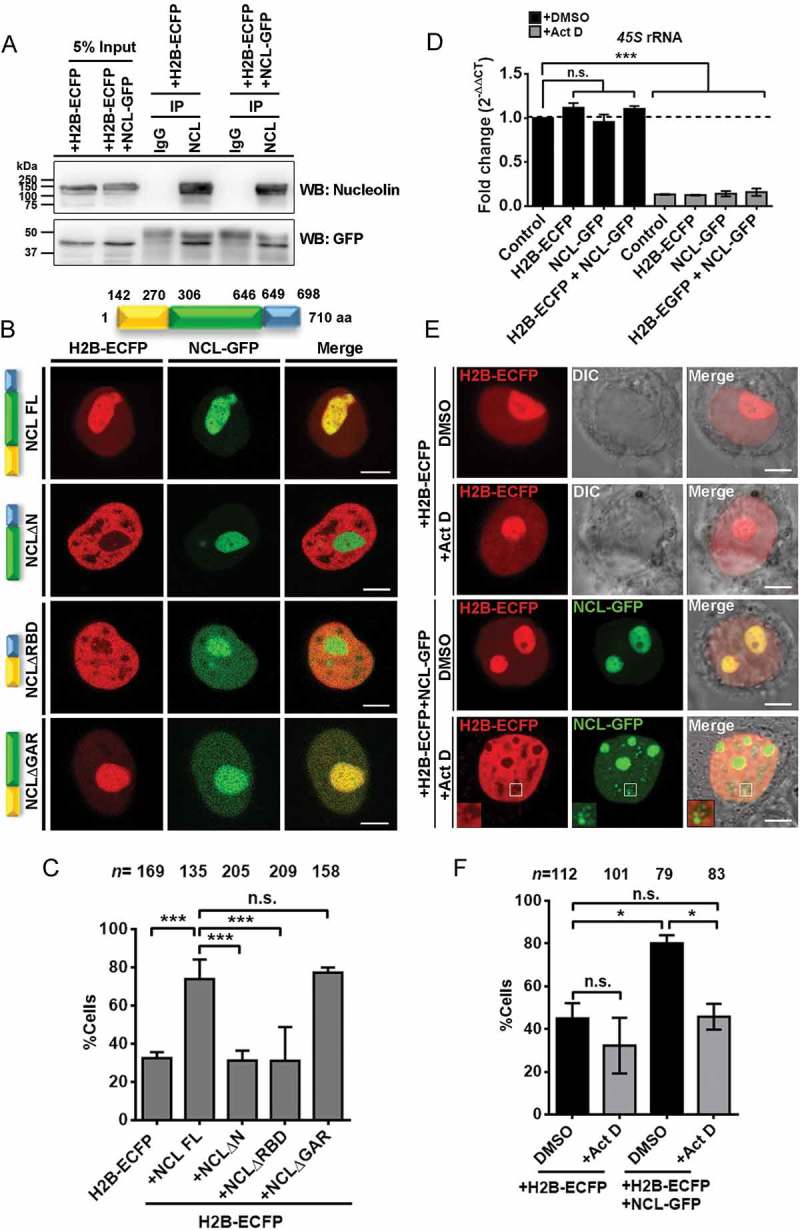
Nucleolin associates with H2B-ECFP in the nucleolus. (a) Co-immunoprecipitation (Co-IP) of endogenous Nucleolin and NCL-GFP with anti-Nucleolin antibody reveals its interaction with H2B-ECFP. Normal IgG used as a control for Co-IP. Anti-GFP antibody was used in western blot to detect H2B-ECFP. Data from N = 2 independent biological replicates. (b) Schematic showing three major domains of Nucleolin. The numbers denote the amino acid positions of the respective domains of Nucleolin. Representative images of DLD1 cells co-transfected with H2B-ECFP and Full length NCL (NCL FL), N-terminal deletion (NCLΔN), RNA binding domain deletion (NCLΔRBD) or GAR domain deletion (NCLΔGAR). H2B-ECFP and FL NCL show co-localization in the nucleolus. NCLΔRBD and NCLΔGAR show nucleoplasmic localization in addition to nucleolar localization. Scale bar, 5 µm. (c) Percent cells showing nucleolar H2B-ECP upon co-expression of NCL FL, NCLΔN, NCLΔRBD and NCLΔGAR, n = number of nuclei, data from N = 3 independent biological replicates, error bars: SEM. ANOVA, ***p < 0.001. (d) qRT-PCR for 45S pre-rRNA in vehicle (DMSO) and Actinomycin D (Act D, 0.05 μg/ml) treated cells, N = 2. 45S pre-rRNA level is downregulated in all cells upon Act D treatment. All statistics performed with respect to Control (+DMSO) cells, ANOVA, ***p < 0.001. (e) Representative images of cells expressing H2B-ECFP alone, or co-expressing NCL-GFP, upon DMSO or Act D treatment. Inset – Nucleolin speckles upon Act D treatment, do not show H2B-ECFP, Scale bar ~5 μm. (f) Quantification of percent cells showing nucleolar H2B-ECFP upon Act D treatment (from e), n = number of nuclei, N = 2 independent biological replicates. ANOVA, *p < 0.05.